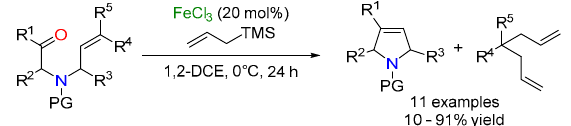
Scheme 14. General reaction equation of published reactions employing allyltrimethylsilane. Scheme 13. General equations of the published reactions by Li. Scheme 13. General equations of the published reactions by Li.